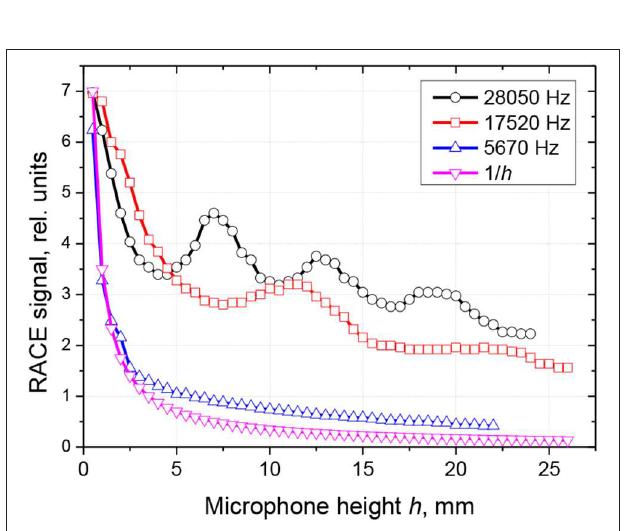
FIGURE 1 | Comparison of RACE and LDR frequency responses for FBH in PMMA plate.